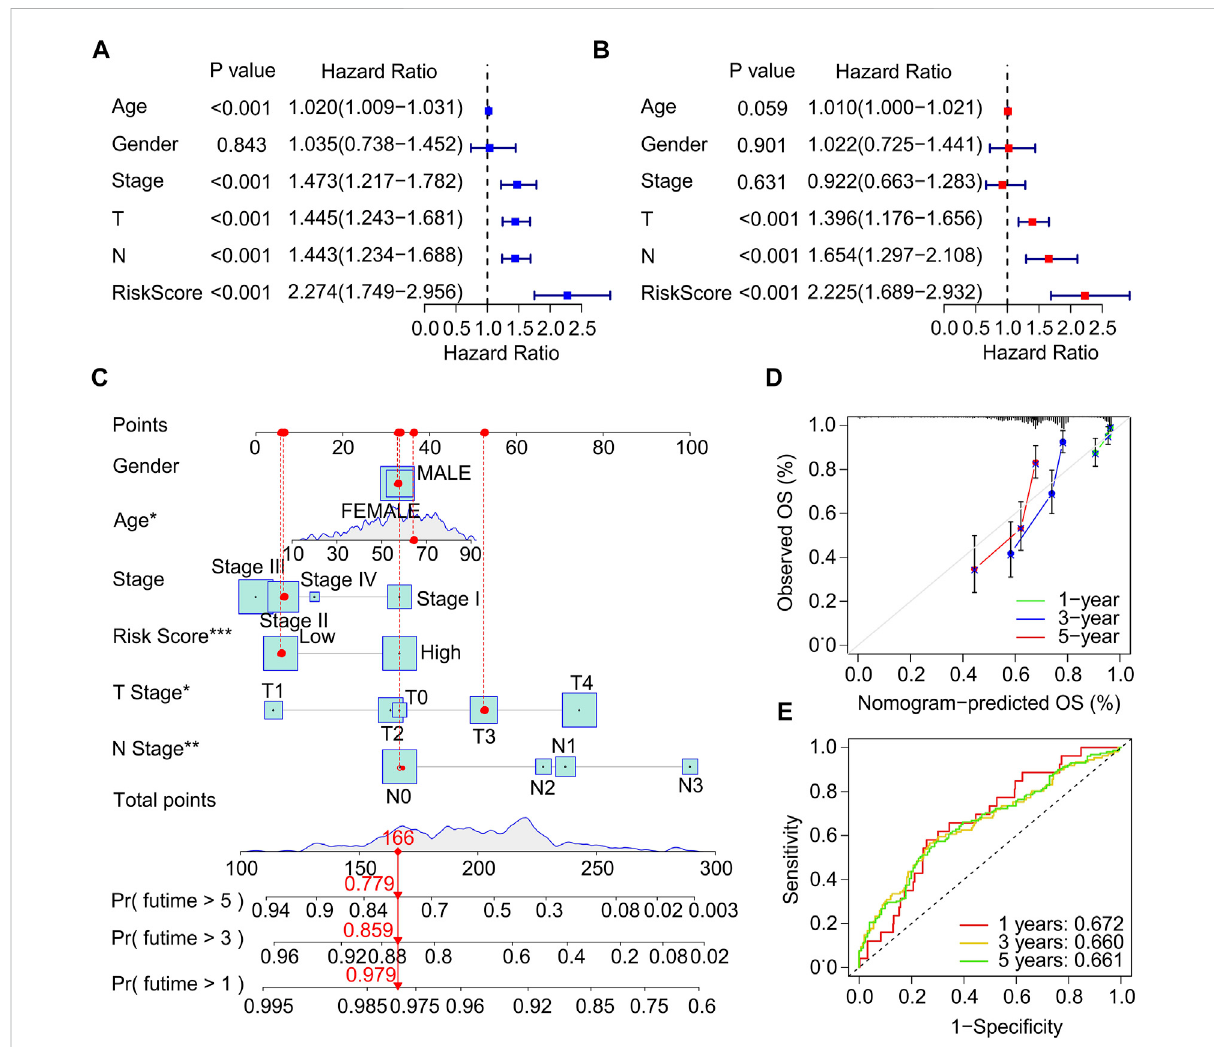
FIGURE 4 Independent prognostic analysis of clinical characteristics and risk score. (A) Univariate Cox regression analysis suggests a clear association between OS rate and clinical characteristics including age, gender, stage, Tstage, Nstage, and therisk score. (B) Multivariate Cox regression analysis indicates that T stage, N stage and risk score are an independent prognostic indicator for CM. (C) Nomogram construction of risk score and clinicopathological characteristics to predict the 1-, 3-, 5-years OS rate of CM patients. (D) Calibration curve shows the accuracy between predictive capacity and actual OS rate of 1-, 3-, and 5-years. (E) Time-dependent ROC curve shows the AUC at 1-, 3-, and